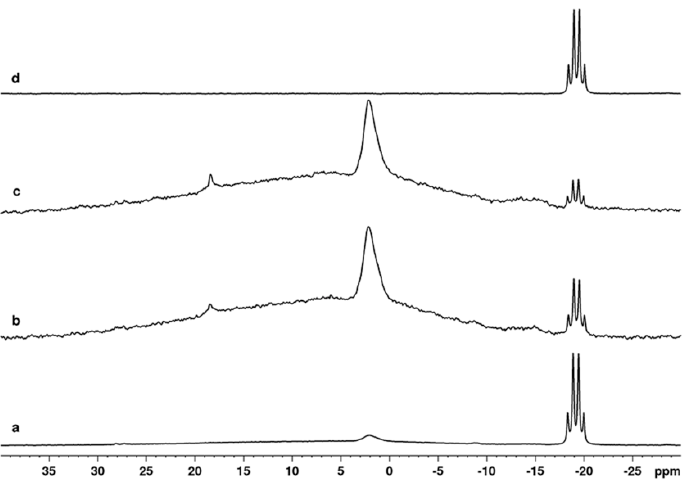
Figure 9. 11 B NMR spectra of mixture of ligand 6 and BH 3 •SMe 2 in toluene-d 8 measured at different time intervals after sample preparation: ( a ) 15 min, ( b ) 3 h 30 min and ( c ) 5 h. The 11 B spectrum of